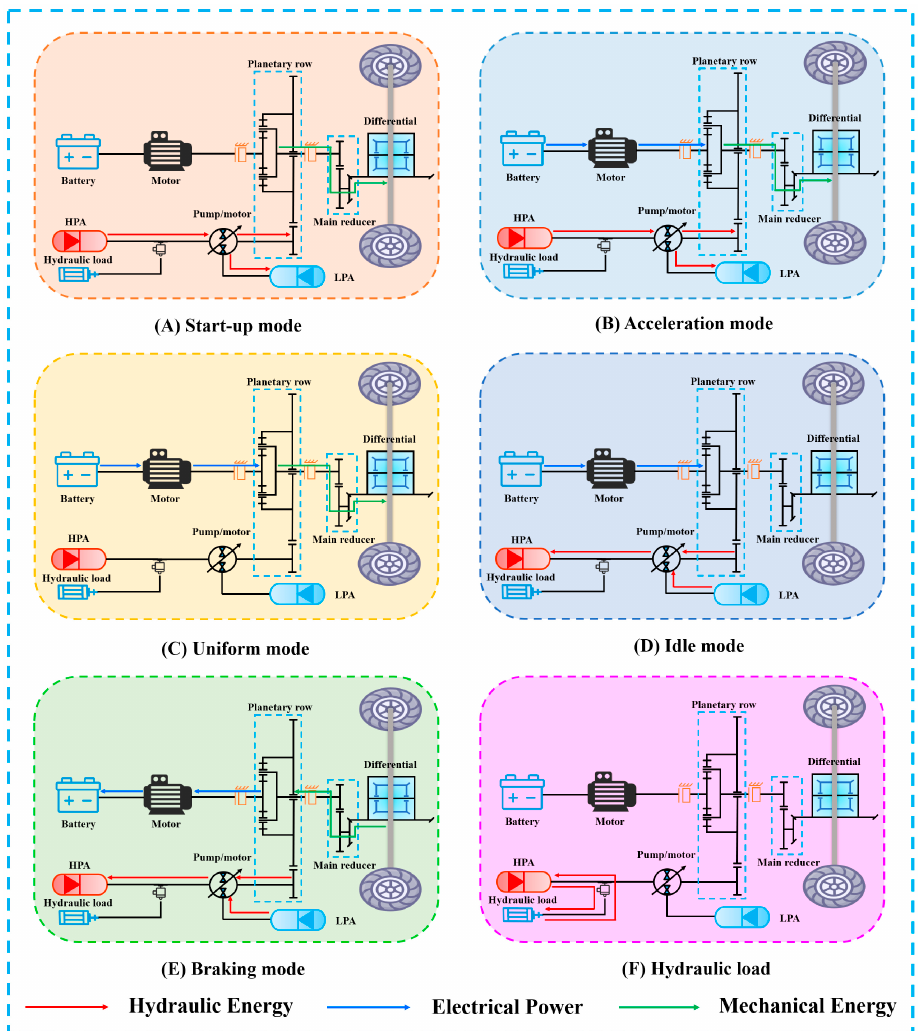
Figure 2. The operating modes of the MSEH-HEV.